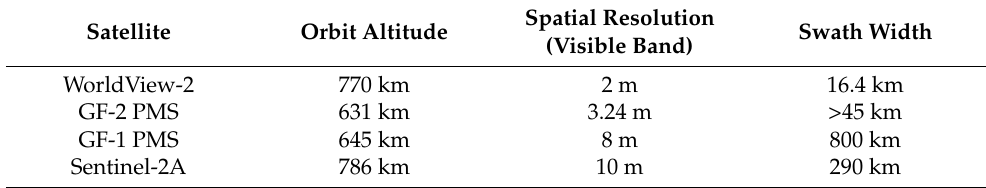
Table 2. Multispectral images used in this paper and their main information. Satellite Orbit Altitude